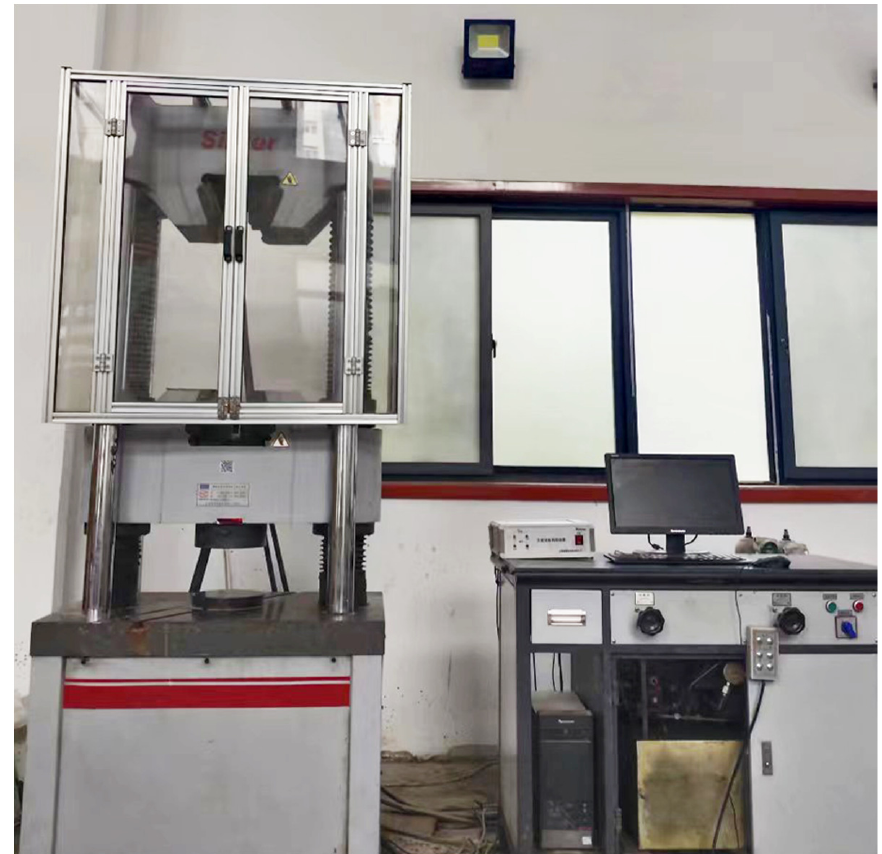
Figure 1. The WAW-1000D microcomputer-controlled electro-hydraulic servo universal testing ma- chine.